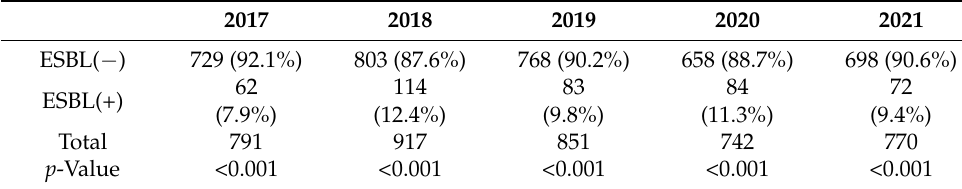
Table 3. Number of E. coli ESBL(+) and ESBL( − ) strains in